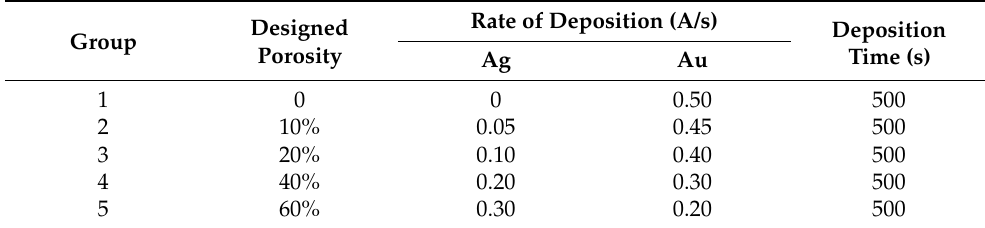
Table 2. Deposition conditions in forming NPG thin film with different porosities on SiO 2 vertical microcavity